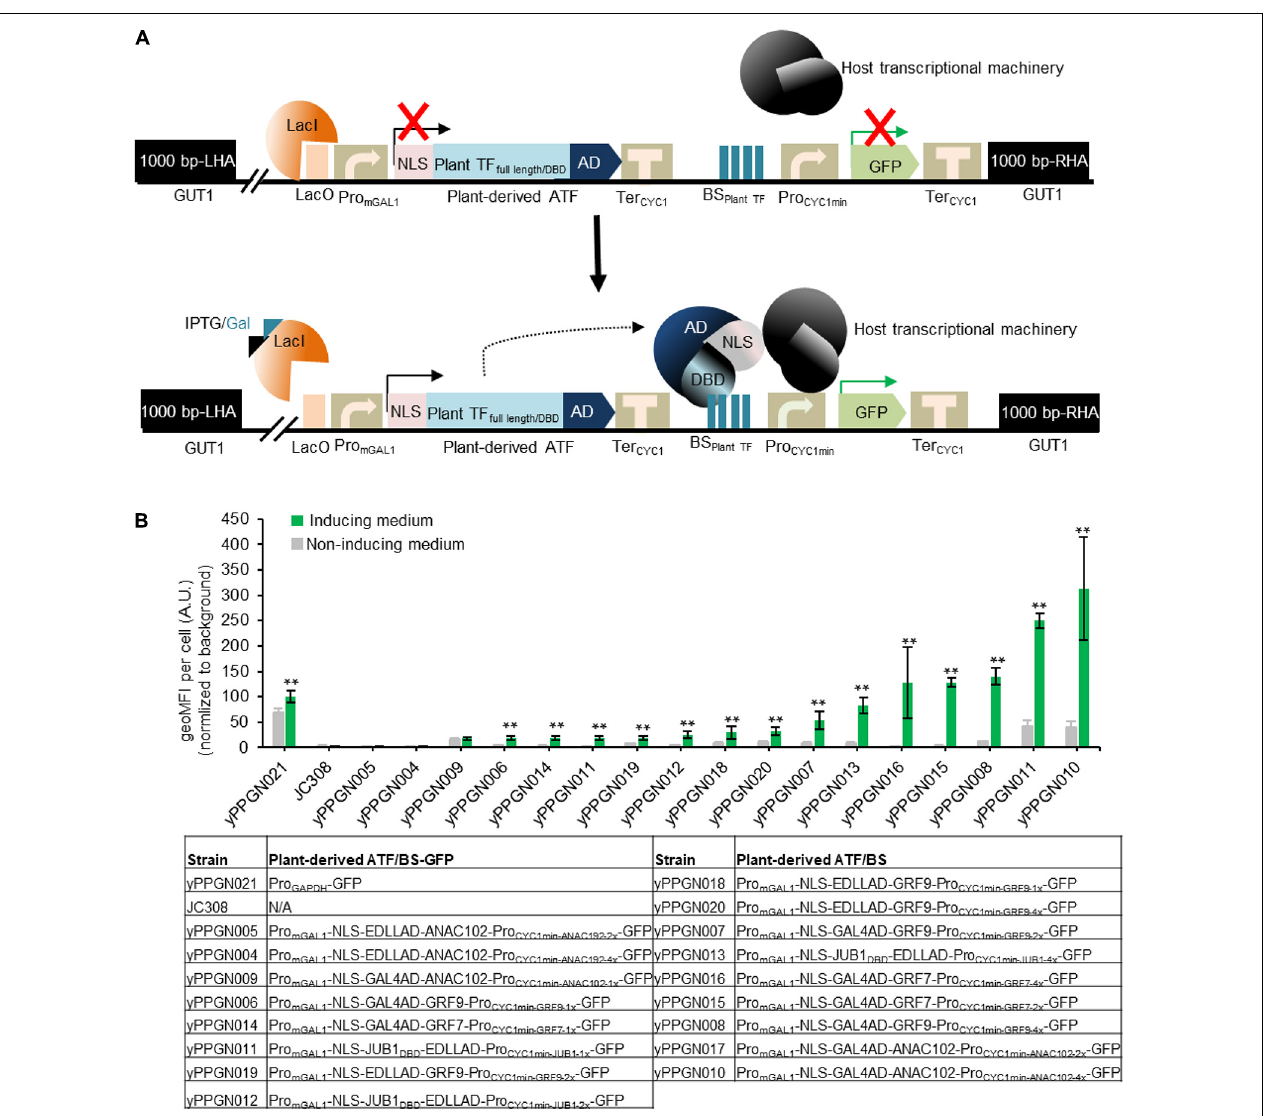
FIGURE 2 | Library of genome-integrated, plant-based ATF/BSs in P. pastoris . (A) Schematic overview of plant-derived ATFs and BSs used in the present study. The ATF cassette contains an mGAL1 promoter with a lacO site at the 5 (cid:48) end (induced by IPTG and galactose), NLS, and full-length plant TFs or their DBDs fused in different combinations with GAL4AD or EDLLAD and Ter CYC 1 . The transactivation capacity of the ATFs was tested against the TF BSs inserted as one (1x), two (2x), or (4x) copies upstream of the CYC1 minimal promoter driving GFP reporter expression. The 1,000-bp LHA and RHA allow integration of the regulator cassette into the GUT1 sites of the genome. The expression of ATFs was controlled by an IPTG-inducible GAL1 promoter. Constitutive expression of the repressor (LacI) inhibits the expression of plant-derived ATFs, while the addition of inducers (IPTG and galactose) results in ATF expression. Binding of the ATF to its cognate BS within the CYC1 minimal promoter drives GFP expression. Fluorescence output is measured in the absence and presence of inducer. AD, activation domain; ATF, artificial transcription factor; BS plantTF , binding site of the plant transcription factor; BS, binding site; DBD, DNA binding domain; GFP, green fluorescent protein; IPTG, isopropyl- β -D-thiogalactopyranoside; GUT1, glycerol utilization 1; LHA, left homology arm; NLS, nucleus localization signal; Pro minCYC 1 , minimal CYC1 promoter; Pro mGAL 1 , modified GAL1 promoter carry LacO site; LacI, Lac repressor; Ter CYC 1 , CYC1 terminator; RHA, right homology arm. (B) Transcriptional output of plant-derived ATF/BSs in P. pastoris . The GFP output was tested in the absence and presence of IPTG and galactose. The types of ATF used to generate yPPGN004—yPPGN020 strains are listed in the table. P. pastoris strain yPPGN021 was used as a positive control, where the GFP expression is controlled by GAPDH promoter allowing constitutive expression of GFP in both inducing- and non-inducing medium. EDLLAD, activation domain from plant; GAL4, GAL4 activation domain of yeast; GRF7 and GRF9, Growth-Regulating Factor 7 and 9; JUB1, NAC TF JUNGBRUNNEN1; ANAC102, A NAC TF 102; VP64AD, viral activation domain. Gray, non-induction medium; green, induction medium. Data are expressed as the geometric mean ± SD of the fluorescence intensity obtained from three cultures, each derived from an independent yeast colony and determined in three technical replicates. Data are normalized to the average geoMFI of the background fluorescence obtained from the wild-type JC308 strain (Lin Cereghinoa et al., 2001). Asterisks indicate a statistically significant difference from the non-induction medium (Student’s t- test; ** p < 0.01). AU, arbitrary units; geoMFI, geometric mean fluorescence. The full data are shown in Supplementary Data 1